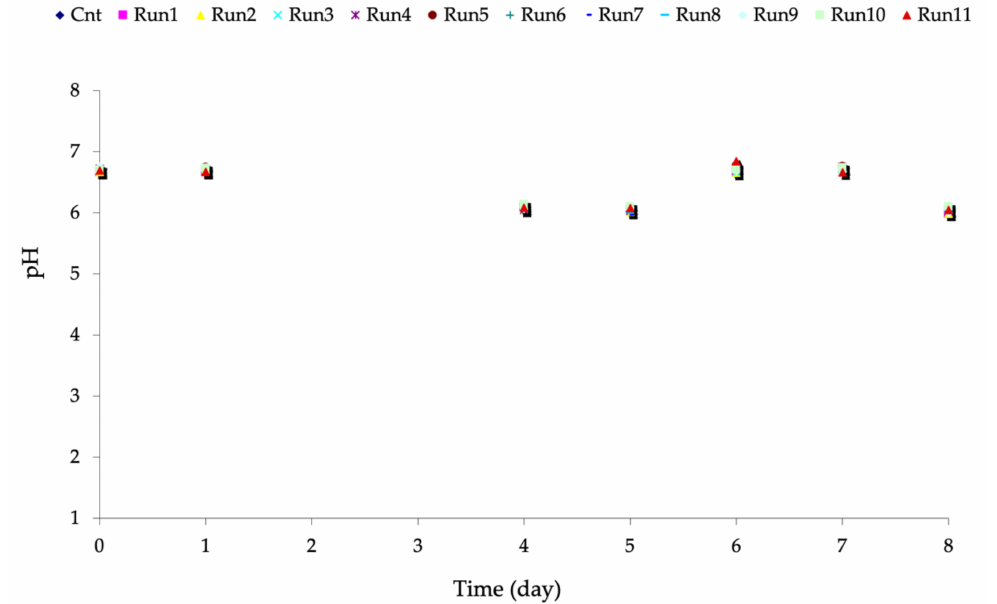
Figure 4. Evolution of pH in Giuncata cheese samples during the storage period (8